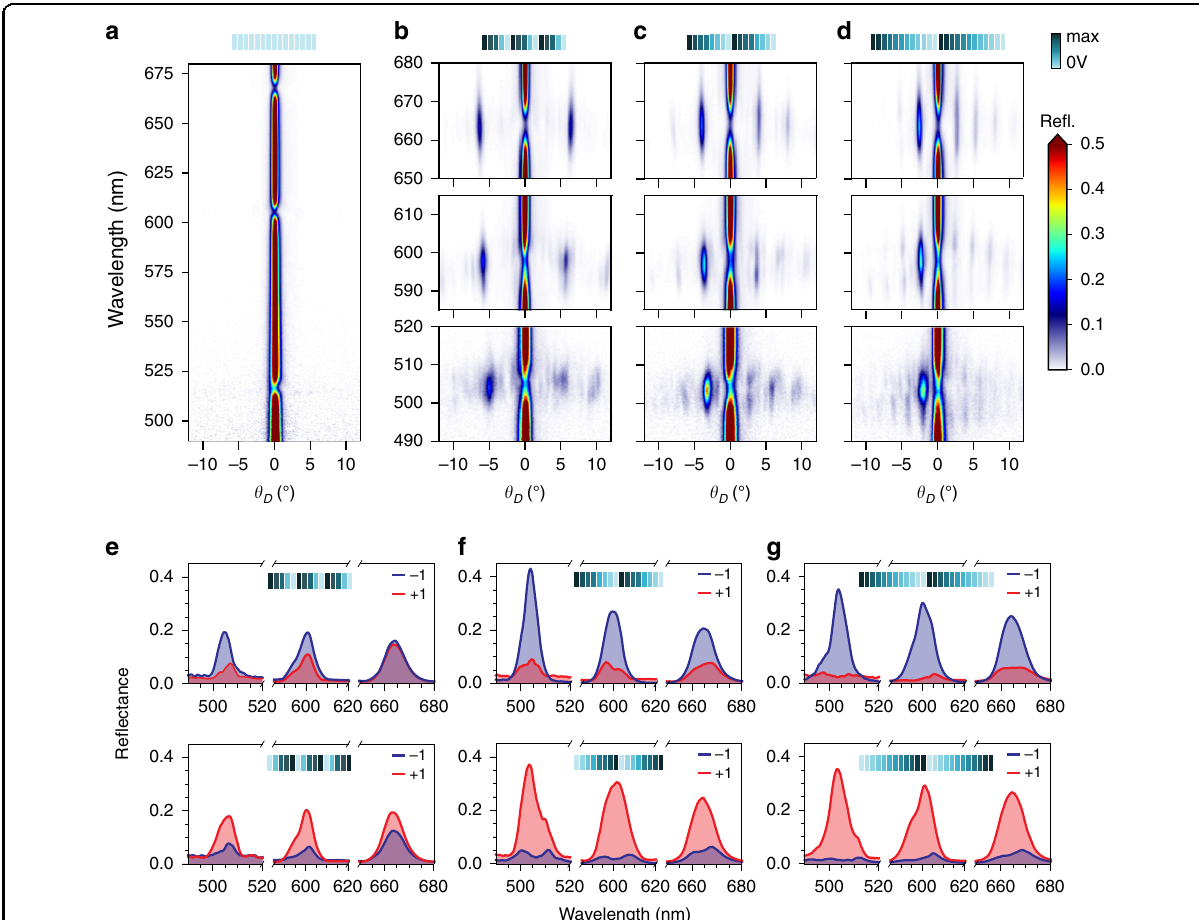
Fig. 4 Programmable beam steering with the FP-SLM. a – d Color maps showing the measured re fl ectance as a function of wavelength and the re fl ection angle: ( a ) when all electrodes are unbiased, and ( b – d ) when voltage patterns are applied to the electrodes creating linear phase pro fi les corresponding to a blazed grating with ( b ) 5-pixels, ( c ) 8-pixels and ( d ) 12-pixels supercells. The voltage patterns are schematically shown on top of the panels. e – g Extracted diffraction (re fl ectance) ef fi ciencies for the main orders supported by the induced gratings ( − 1 st and + 1 st ). The top panels correspond to the cases depicted in ( b – d ), leading to power channeling into the − 1 st order, while the bottom ones correspond to the reversed angle con fi guration, channeling power into the + 1 st